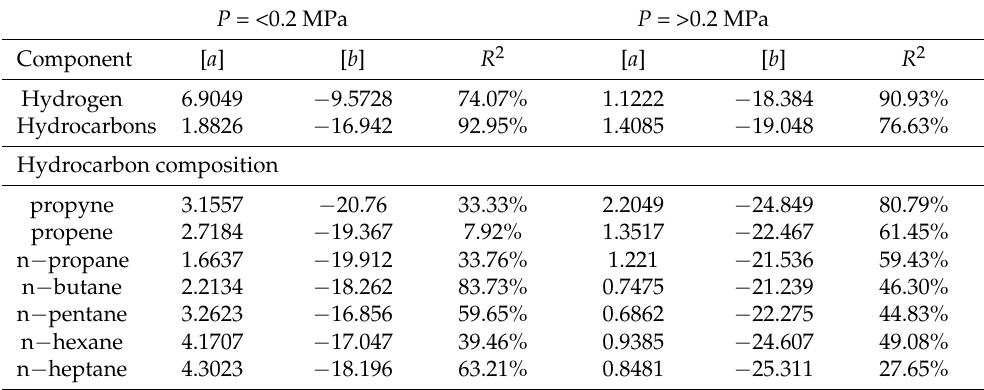
Table 6. Rate constant for the gases in Table 5. Ln k f = [ a ] Log [ P ] + [ b ], where [ a ] and [ b ] are regression constants. R 2 = coefficient of determination.